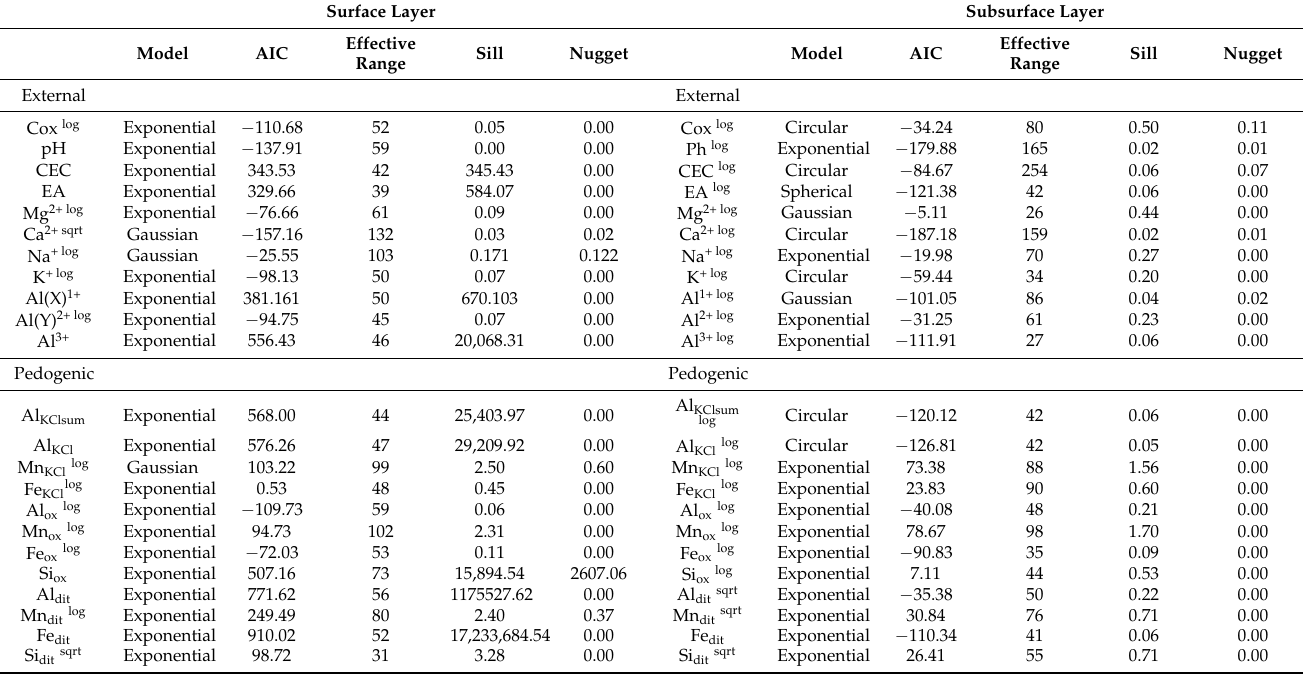
Table 2. Results of variograms parameters, range, sill, and nugget, and the statistical transfor- mations of each soil chemical property (N = 309 samples for the surface and 309 samples for the subsurface